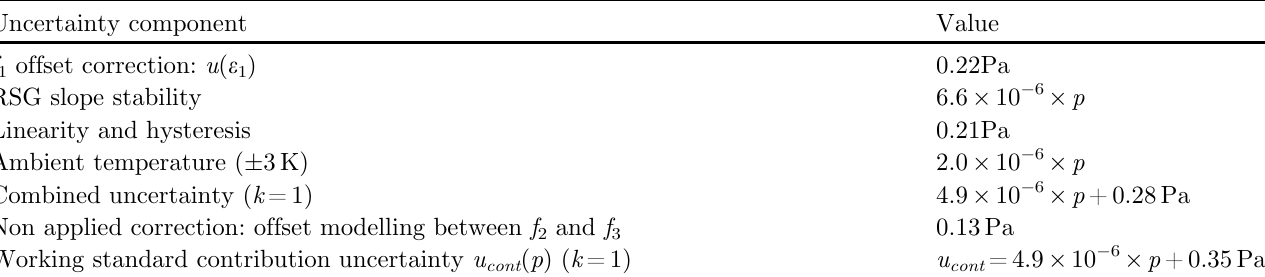
Table 4. Uncertainty budget in the contribution of the working